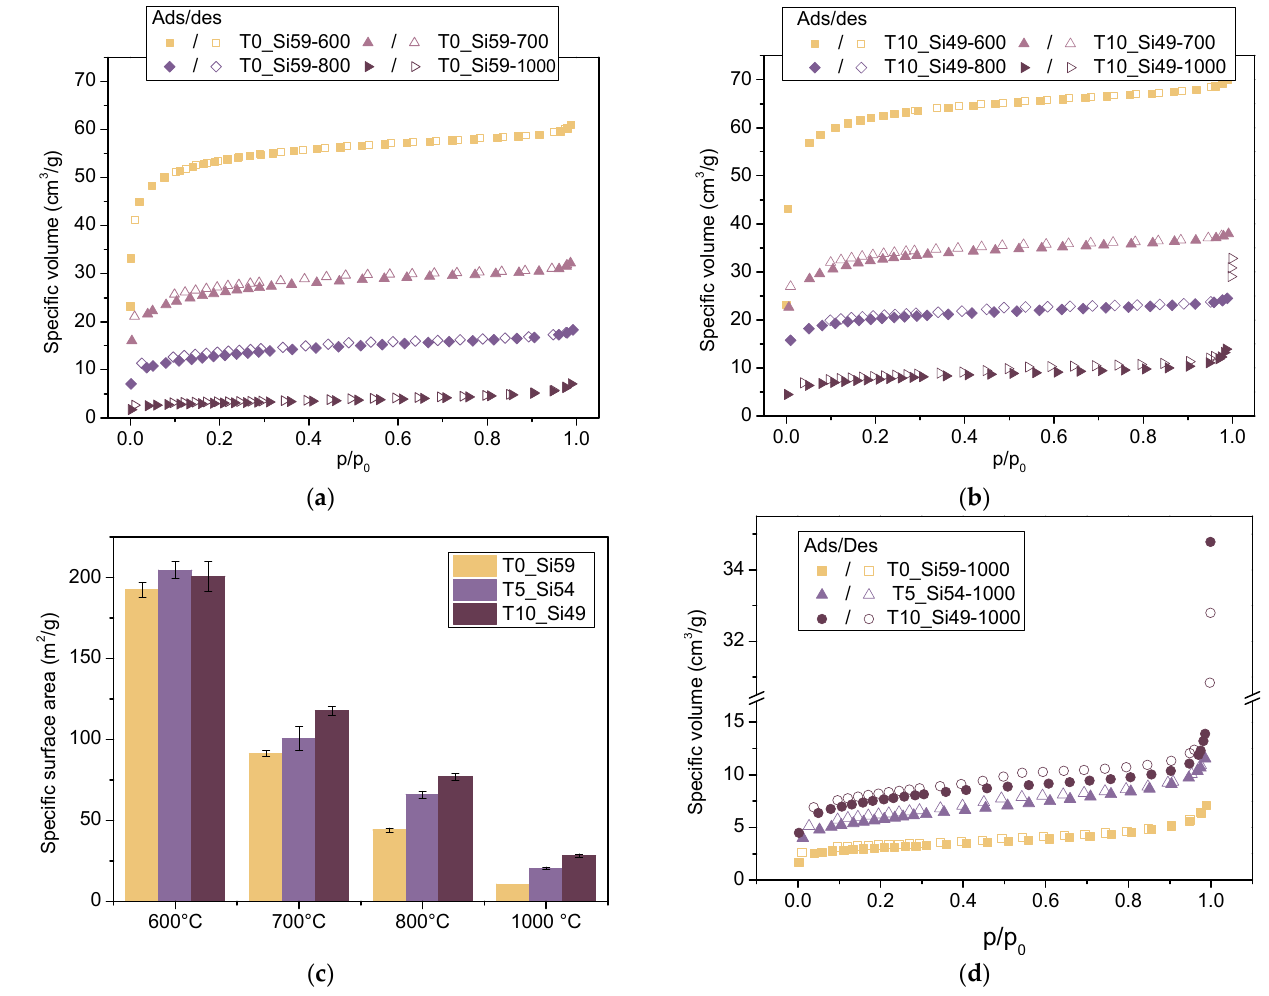
Figure 5. Nitrogen adsorption isotherms for samples ( a ) T0-Si59 and ( b ) T10-Si49. ( c ) BET-specific surface area for all of the samples at different pyrolysis temperatures (600–1000 °C). ( d ) Isotherms for the samples pyrolyzed at 1000 °C.